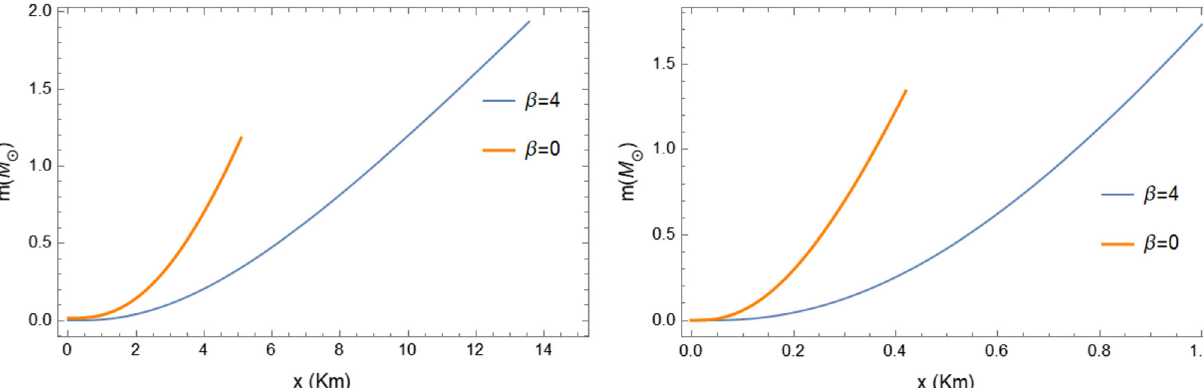
Fig. 4 Variation of the sound speed with radial coordinate x inside the stellar interior